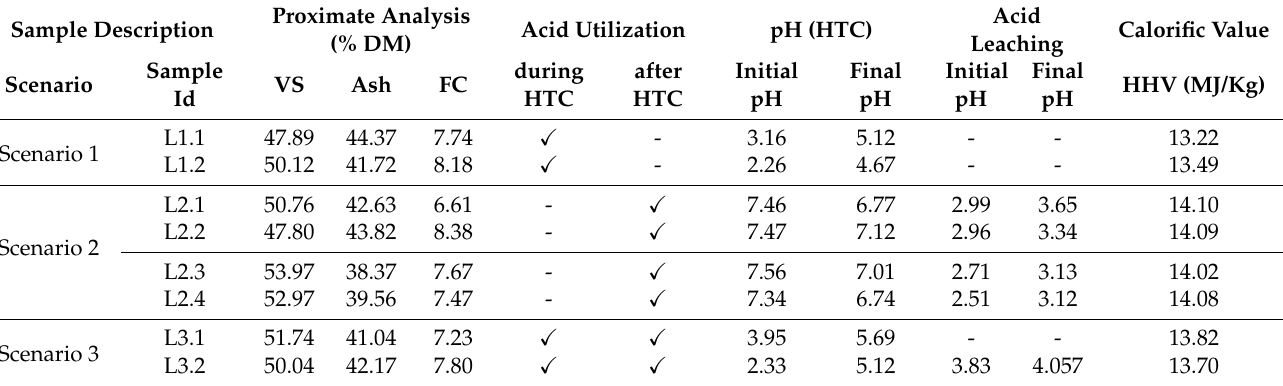
Table 3. Proximate analysis and calorific value of hydrochar produced under different reaction